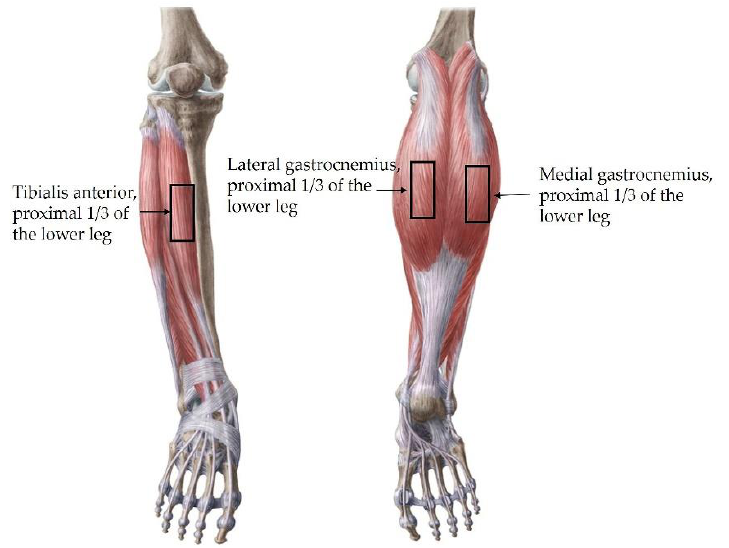
Figure 3. Sites of recording of thickness and stiffness tibials anterior ( left ), and gastrocnemius medial, lateral ( right ).